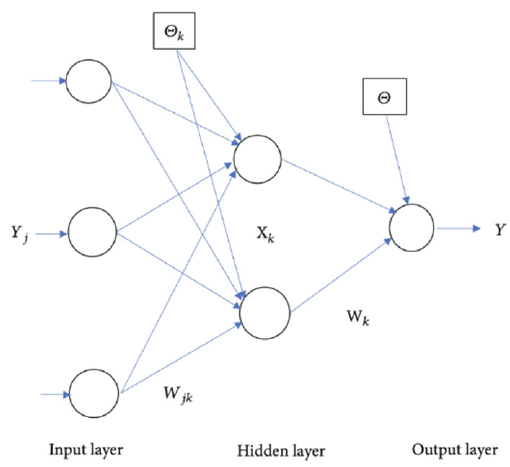
Figure 4. Artificial Neural Network for time series forecasting.